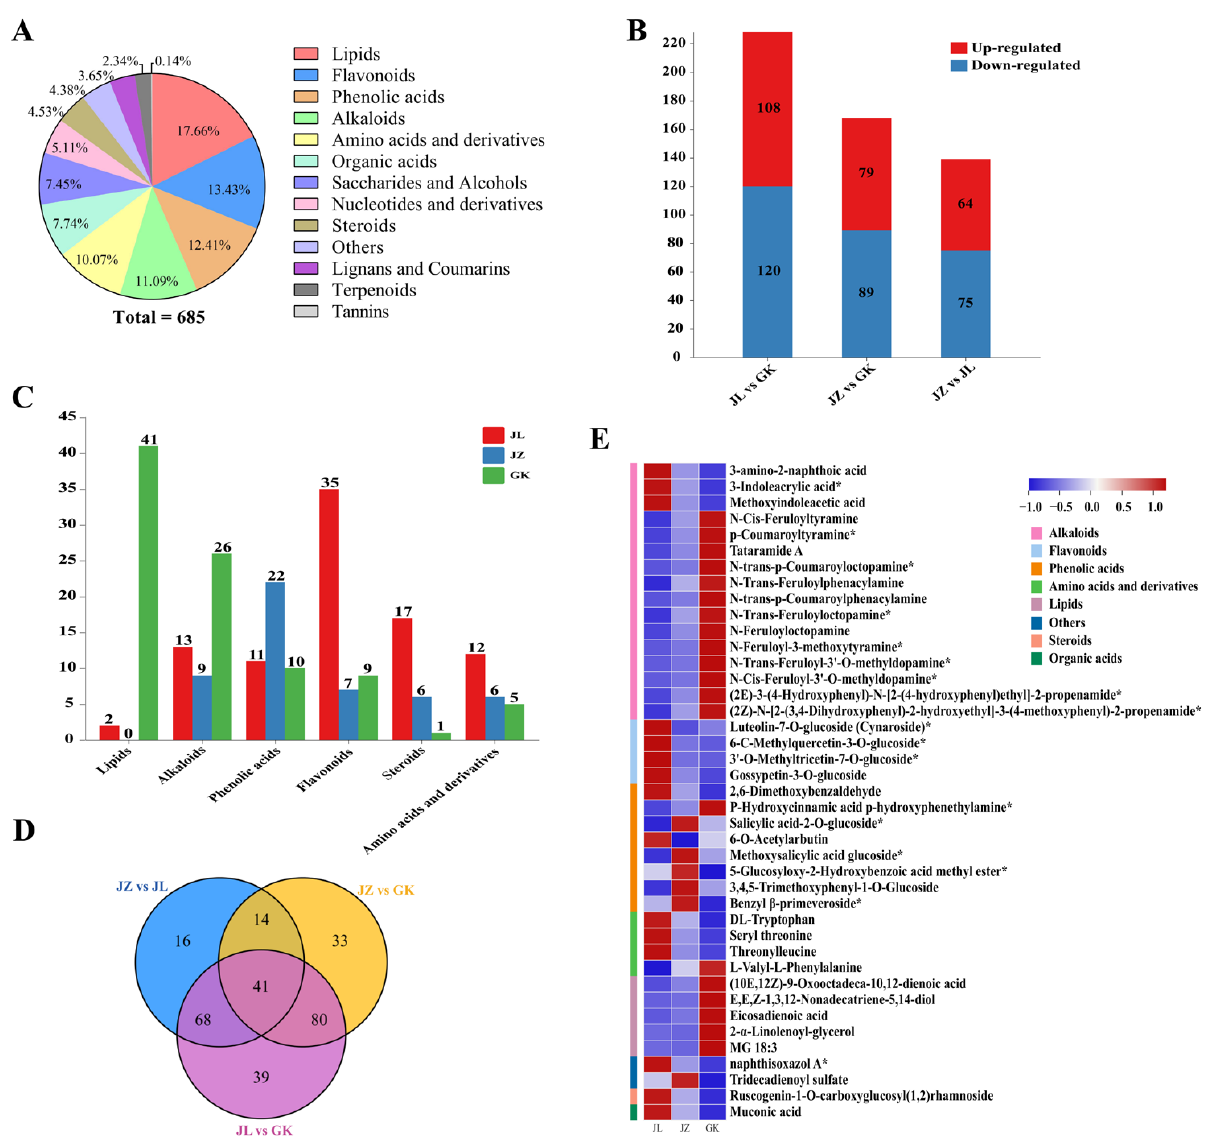
Figure 2. Widely targeted metabolomic analysis of rhizomes from JL, JZ, and GK germplasms in P. cyrtonema . ( A ) Metabolite classification. ( B ) Up-regulated and down-regulated differential metabolites. Red boxes represent up-regulation, and blue boxes represent down-regulation. ( C ) The relative amounts of the highest differential metabolites in the three germplasms. Red boxes represent JL germplasm, blue boxes represent JZ germplasm, and green boxes represent GK germplasm. ( D ) Venn diagram of differential metabolites. ( E ) Heat map of 41 key differential metabolites , "*" indicates an isomer .